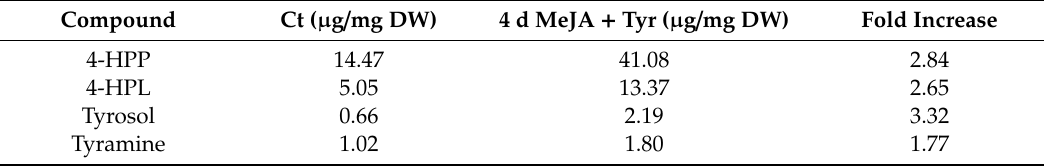
Table 1. Quantification of aromatic compounds determined by 1 H NMR